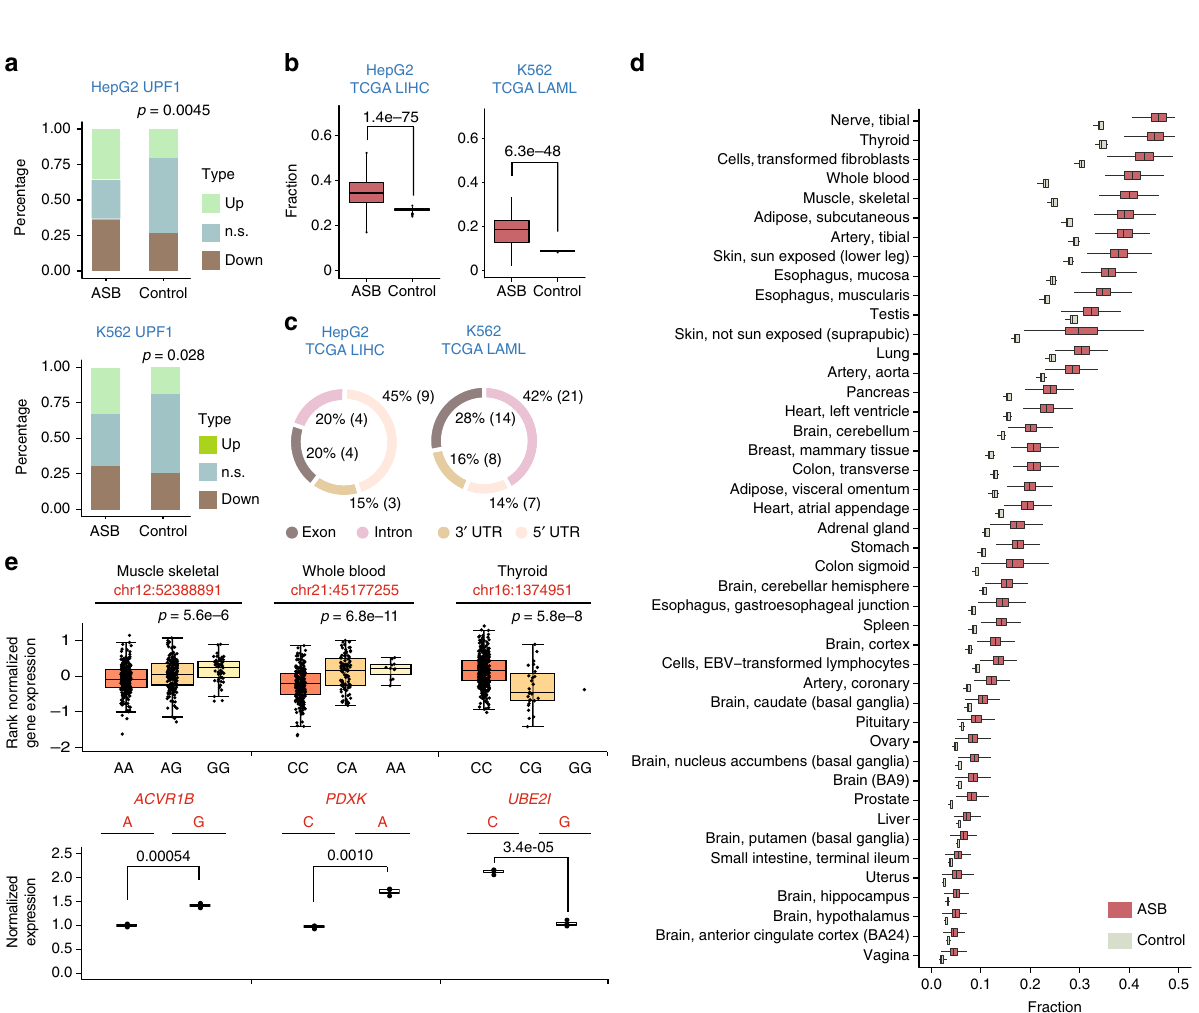
Fig. 5 Functional relevance of allele-speci fi c binding (ASB) single-nucleotide variants (SNVs) in regulating messenger RNA (mRNA) abundance. a Fraction of differentially expressed genes (up- or down-regulated, false discovery rate (FDR) <10%) upon UPF1 knockdown in HepG2 or K562 cells. n.s.: not signi fi cant. Data for genes with ASB SNVs of UPF1 in their 3 ′ -untranslated regions (3 ′ -UTRs) and control genes are shown, where the controls were chosen as genes without UPF1 enhanced crosslinking and immunoprecipitation (eCLIP) peaks and with similar expression levels as UPF1 targets (within + / − 30% of RPKM). P values were calculated to test the null hypothesis that UPF1 ASB target genes are not enriched with up-regulated expression upon UPF1 knockdown (KD), compared to controls (binomial test). b Fraction of ASB SNVs located in expression quantitative trait loci (eQTL) genes among the union of ASB SNVs of all RNA-binding proteins (RBPs) of each cell line. eQTL genes were extracted from the The Cancer Genome Atlas (TCGA) project for liver hepatocellular carcinoma (LIHC) and acute myeloid leukemia (LAML), respectively, to match the cell type of HepG2 and K562. This fraction was calculated for each sample individually, with the distribution of all samples shown in the box plots. Control: fraction of control SNVs located in eQTL genes where control SNVs were randomly chosen from heterozygous SNVs located within genes. P values were calculated by pair-wise t- test. c Genomic context of ASB SNVs that are heterozygous in TCGA samples and located in the eQTL genes. Exon: coding exons; no non-coding transcripts existed among eQTL genes included in this analysis. d Similar as ( b ), for eQTL genes in GTEx tissues. e Expression of minigenes carrying alternative alleles of ASB SNVs in the 3 ′ -UTR of mCherry. mCherry expression measured via real-time quantitative reverse transcription PCR (qRT-PCR) was normalized by that of eYFP (driven by bi- directional promoters). Three biological replicates were analyzed. P values were calculated by Student ’ s t -test. Box plots (top) show the normalized gene expression values of the host genes in selected GTEx tissues, grouped by genotypes of the ASB SNV (coordinates shown above box plots). The expression values and eQTL p values were obtained from the GTEx portal 33 . Boxplot center lines indicate the median and the boxes extend to lower and upper quartiles with whiskers depicting 1.5 interquartile range (IQR). (Source data are provided as a Source Data fi